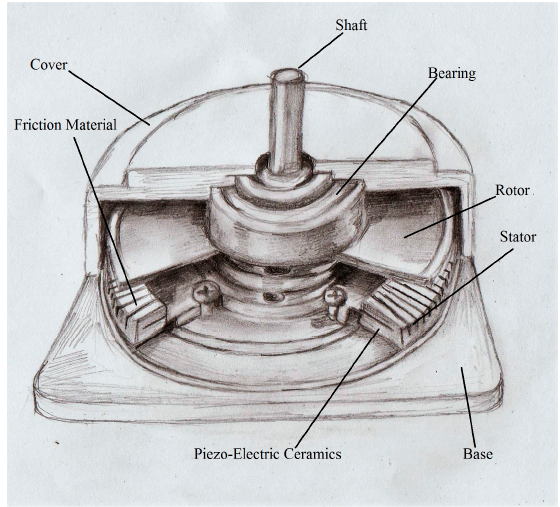
Figure 1. Structure of the ultrasonic motor described in [18].